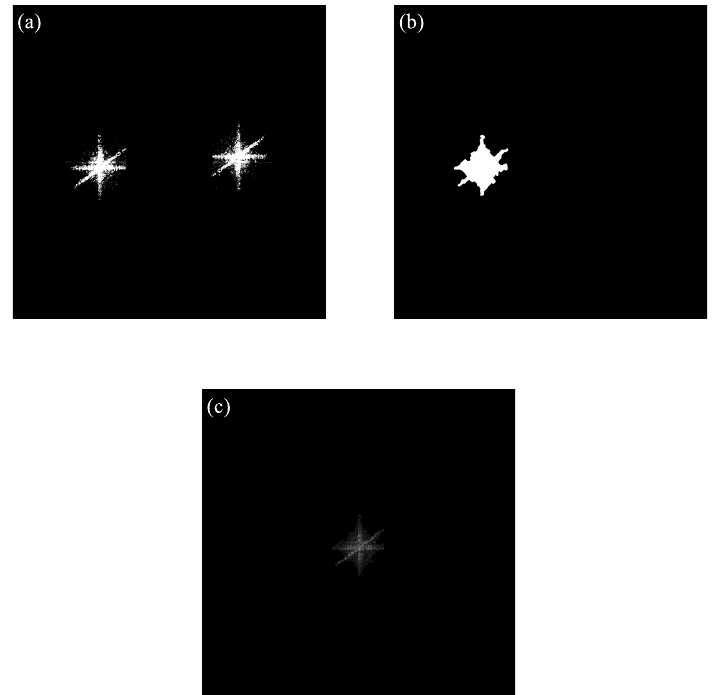
Figure 6. ( a ) Merging; ( b ) binary mask; ( c ) centering after filtering.